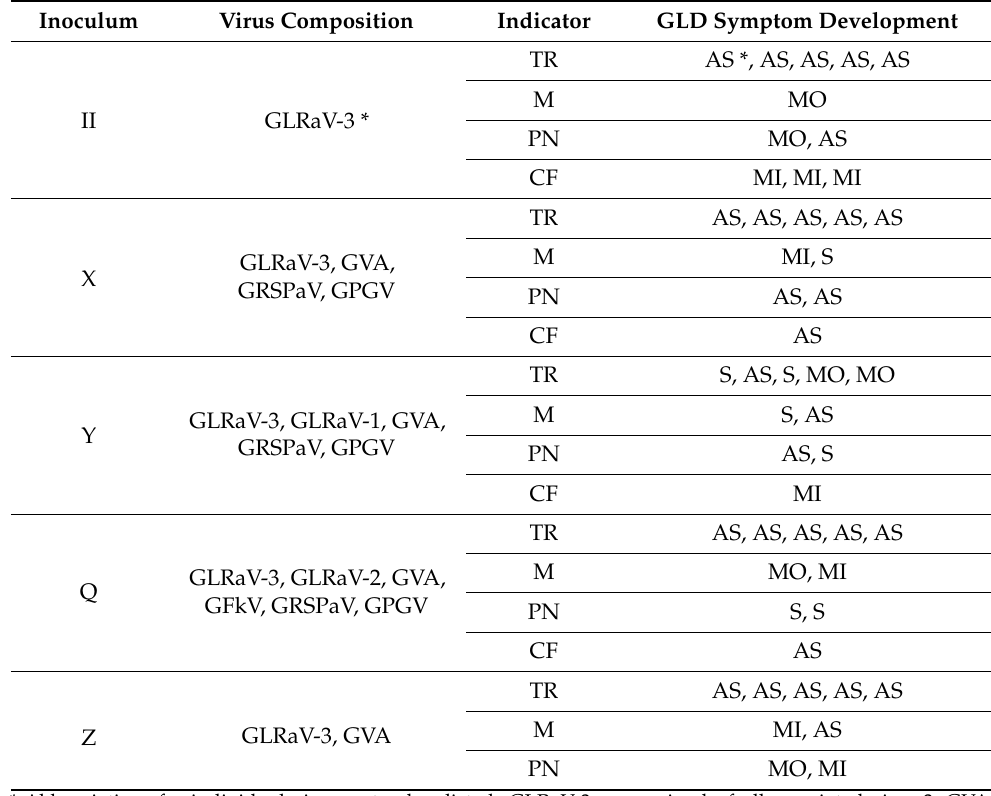
Table 3. Grapevine leafroll disease symptoms’ development in different grapevine indicators inocu- lated with different virus combinations (inocula). Inoculum Virus Composition Indicator GLD Symptom